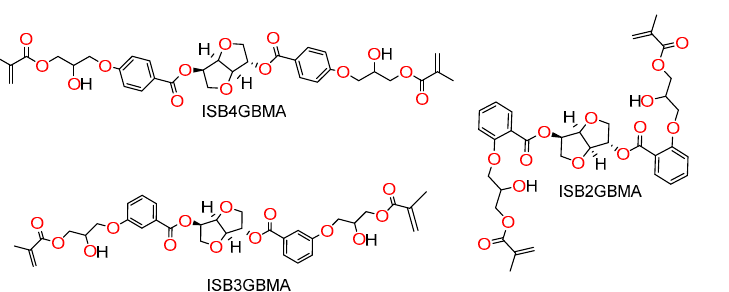
Figure 2. Hydrophobically modified isosorbide dimethacrylates with a para, meta, and ortho aromatic spacer.